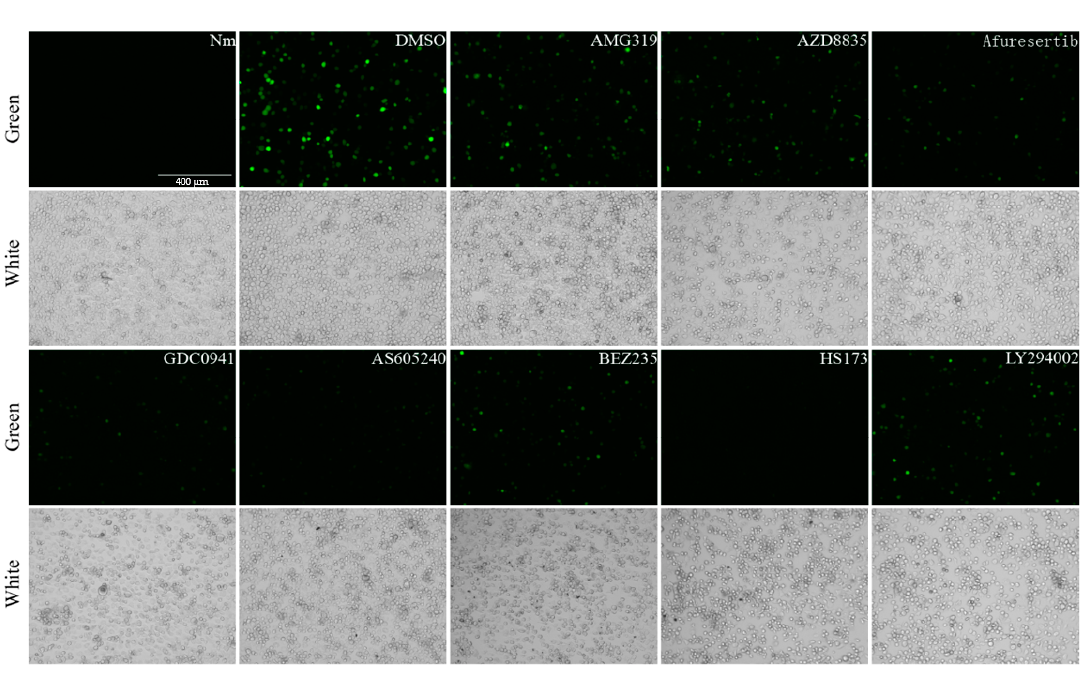
Figure 2. Observation of viral fluorescence at 72 hpi in BmE cells that were infected with BmNPV-GFP expressing green fluorescent protein at multiplicity of infection of 1 (MOI 1) and administered 10 µM of each drug. DMSO: the cells were infected with virus and dimethylsulfoxide (DMSO). Nm: non-infected control.